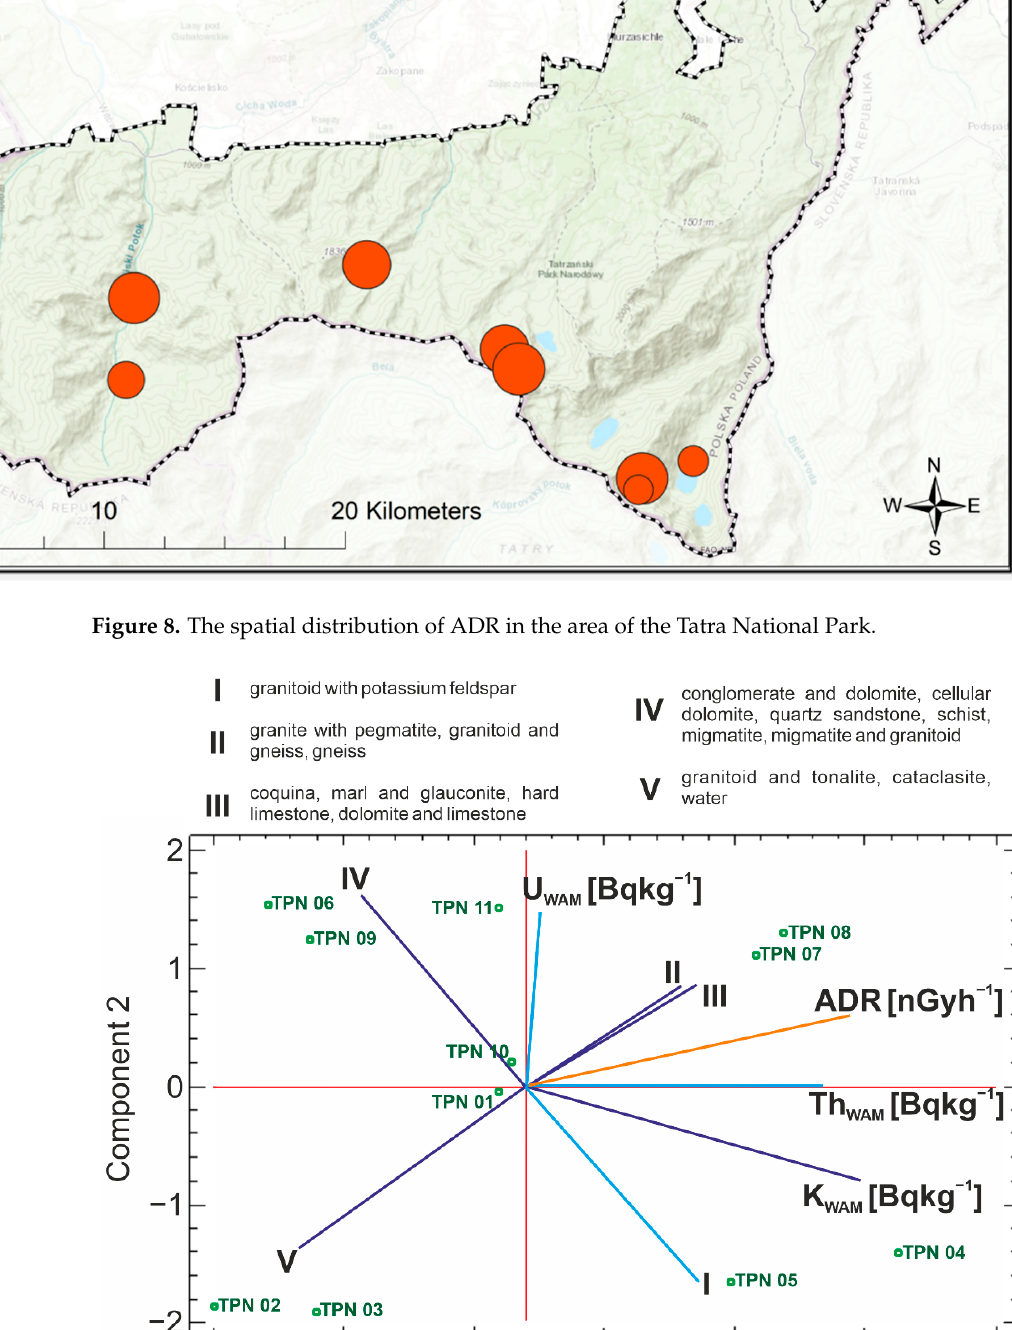
Table 4. Principal Components Analysis.